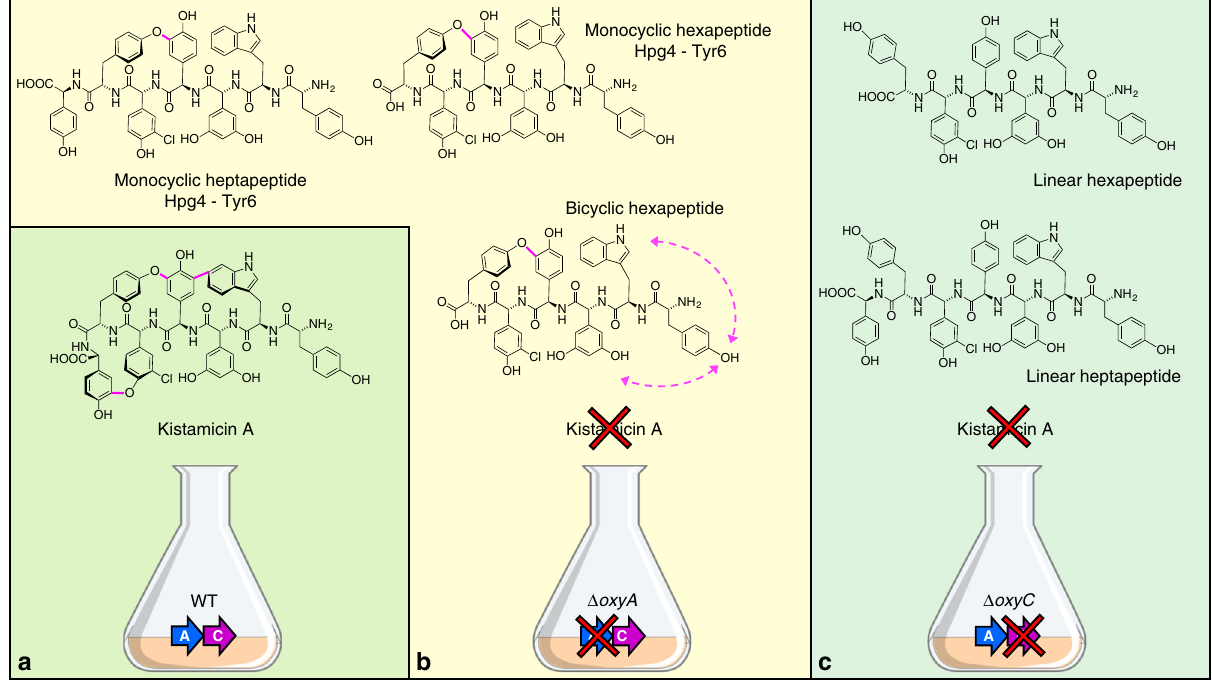
Fig. 2 Production of kistamicin intermediates in A. parvosata WT and Δ oxy mutants. a A. parvosata wildtype (WT) produces kistamicin A, a tricyclic heptapeptide. b A. parvosata Δ oxyA ( Δ kisN ) produces several intermediates from kistamicin biosynthesis, including monocyclic hexa-/heptapeptides and different bicyclic hexapeptides (all structures contain the Tyr-6/ Hpg-4 C- O -D crosslink but display alternate off pathway cyclisation at the peptide N-terminus). c A. parvosata Δ oxyC ( Δ kisO ) produces only the linear hexa-/heptapeptide intermediates from kistamicin